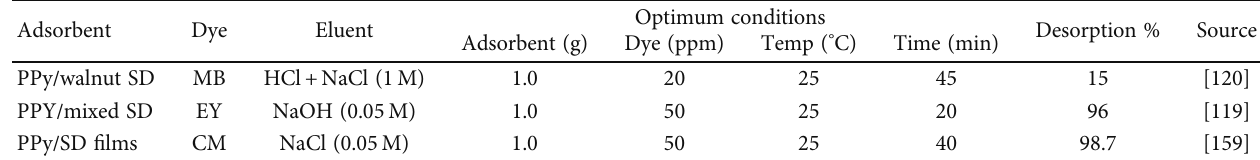
Table 7: Optimum conditions for desorption studies of few PPy/Sd